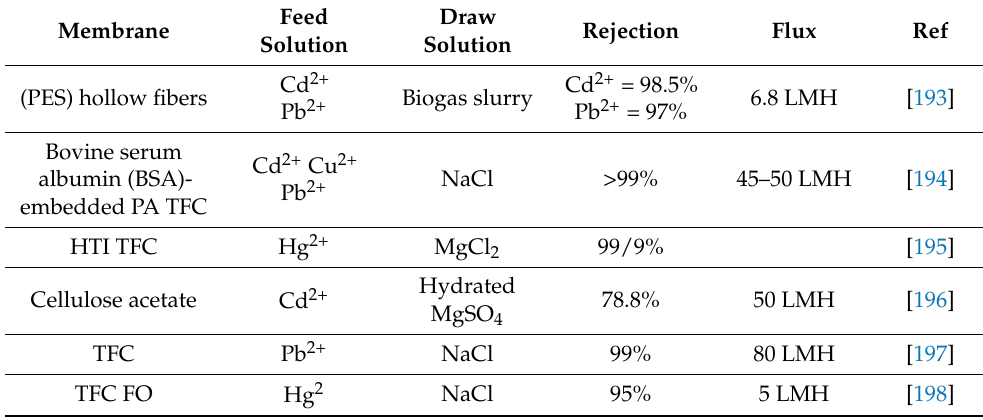
Table 9. Performance evaluation of FO membranes in heavy metal removal applications [184,192].